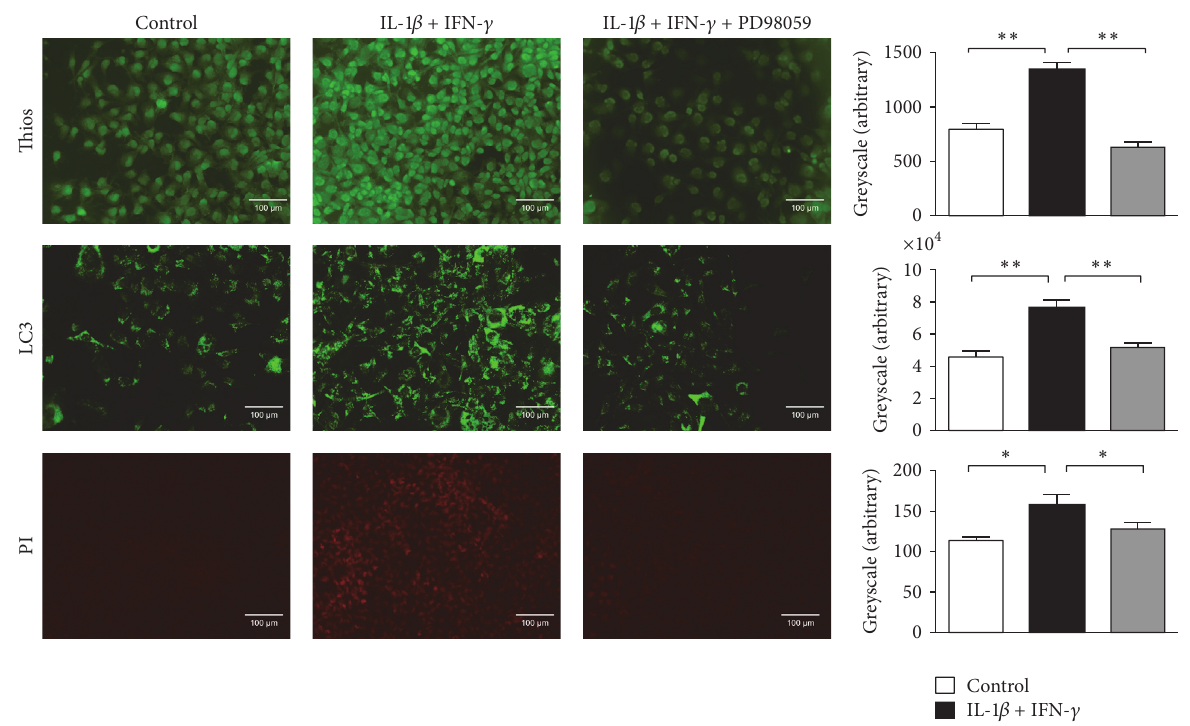
Figure 4: ERK inhibition diminishes amyloid formation and reduces autophagy. Immunofluorescence analysis revealed an increase in thioflavin-S fluorescence in human myoblasts incubated with IL-1 𝛽 and IFN- 𝛾 for 48 hours. This was reversed after inhibition of the ERK pathway via PD98059. IL-1 𝛽 and IFN- 𝛾 induced accumulation of autophagosomes in GFP-LC3-transfected rhabdomyosarcoma cells. Inhibition of the ERK pathway led to reduced autophagy. Quantitative greyscale analysis was performed using Image J and results are shown as standard error of mean of three independent experiments. Exposure of human myoblasts to IL-1 𝛽 and IFN- 𝛾 led to an increased cell death, demonstrated by propidium iodide (PI) staining. Treatment with the ERK inhibitor PD98059 partially prevented cell death. Quantitative greyscale analysis was performed using Image J and results are shown as standard error of mean of three independent experiments. ∗ 𝑝 < 0.05 and ∗∗ 𝑝 < 0.01